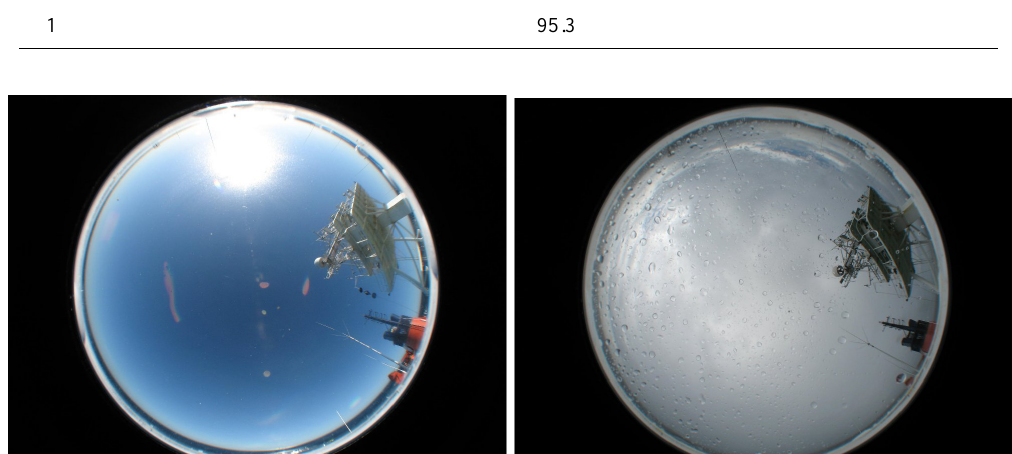
Fig. 2. Segmentation for optical thick clouds (top) and clear sky (bottom) using a treshold of R/B = 0 . 8 (middle) and a treshold of R − B = 30 (right).